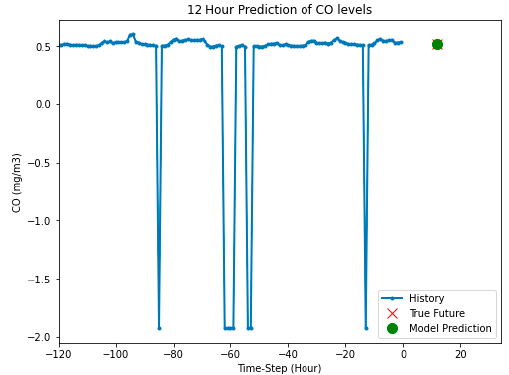
Figure 11. LSTM forecasting for 12 h.